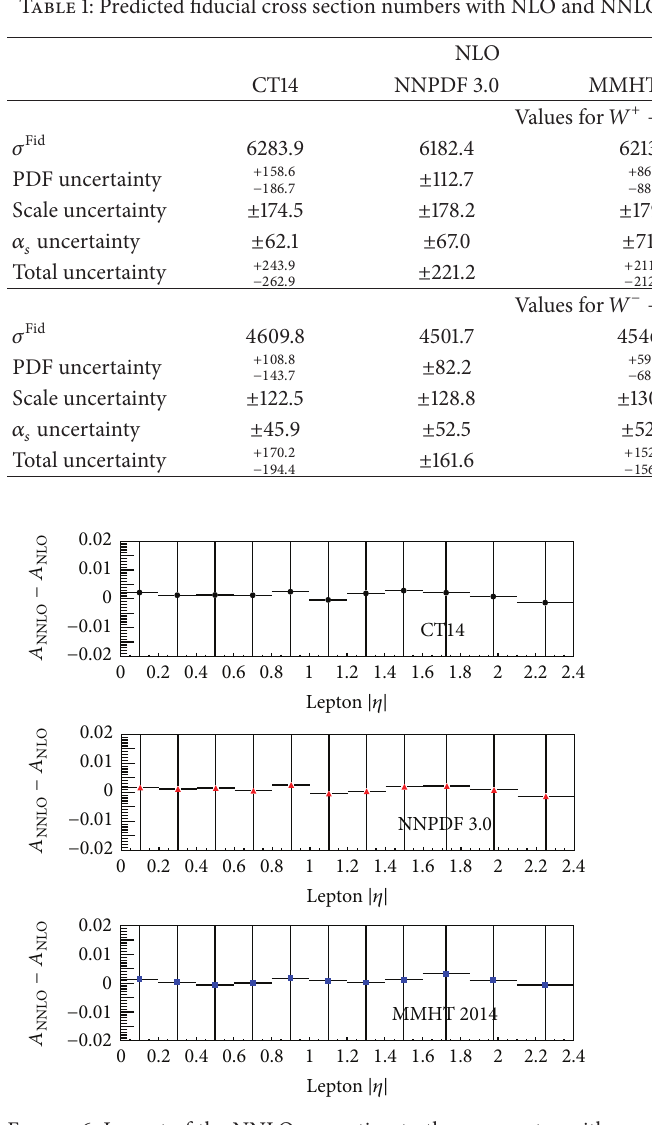
Figure 6: Impact of the NNLO correction to the asymmetry with NLO QCD